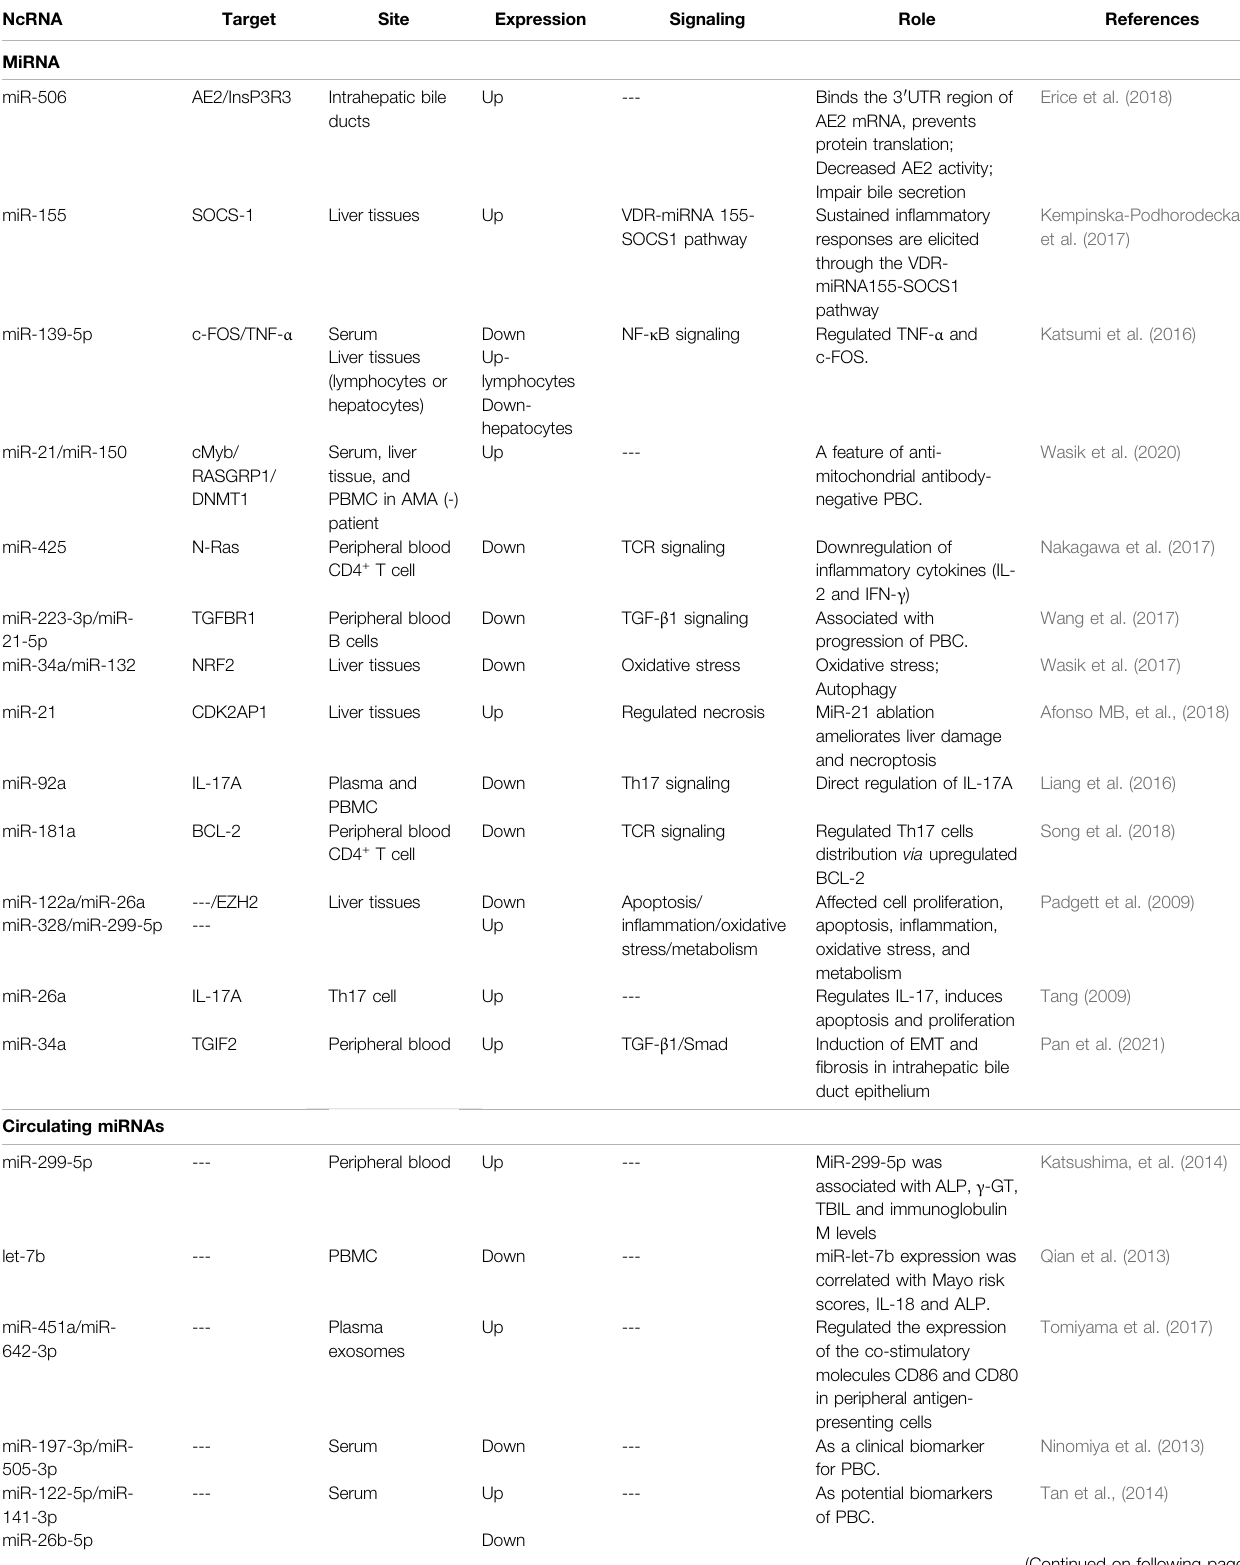
TABLE 1 | Aberrant expressed ncRNAs in